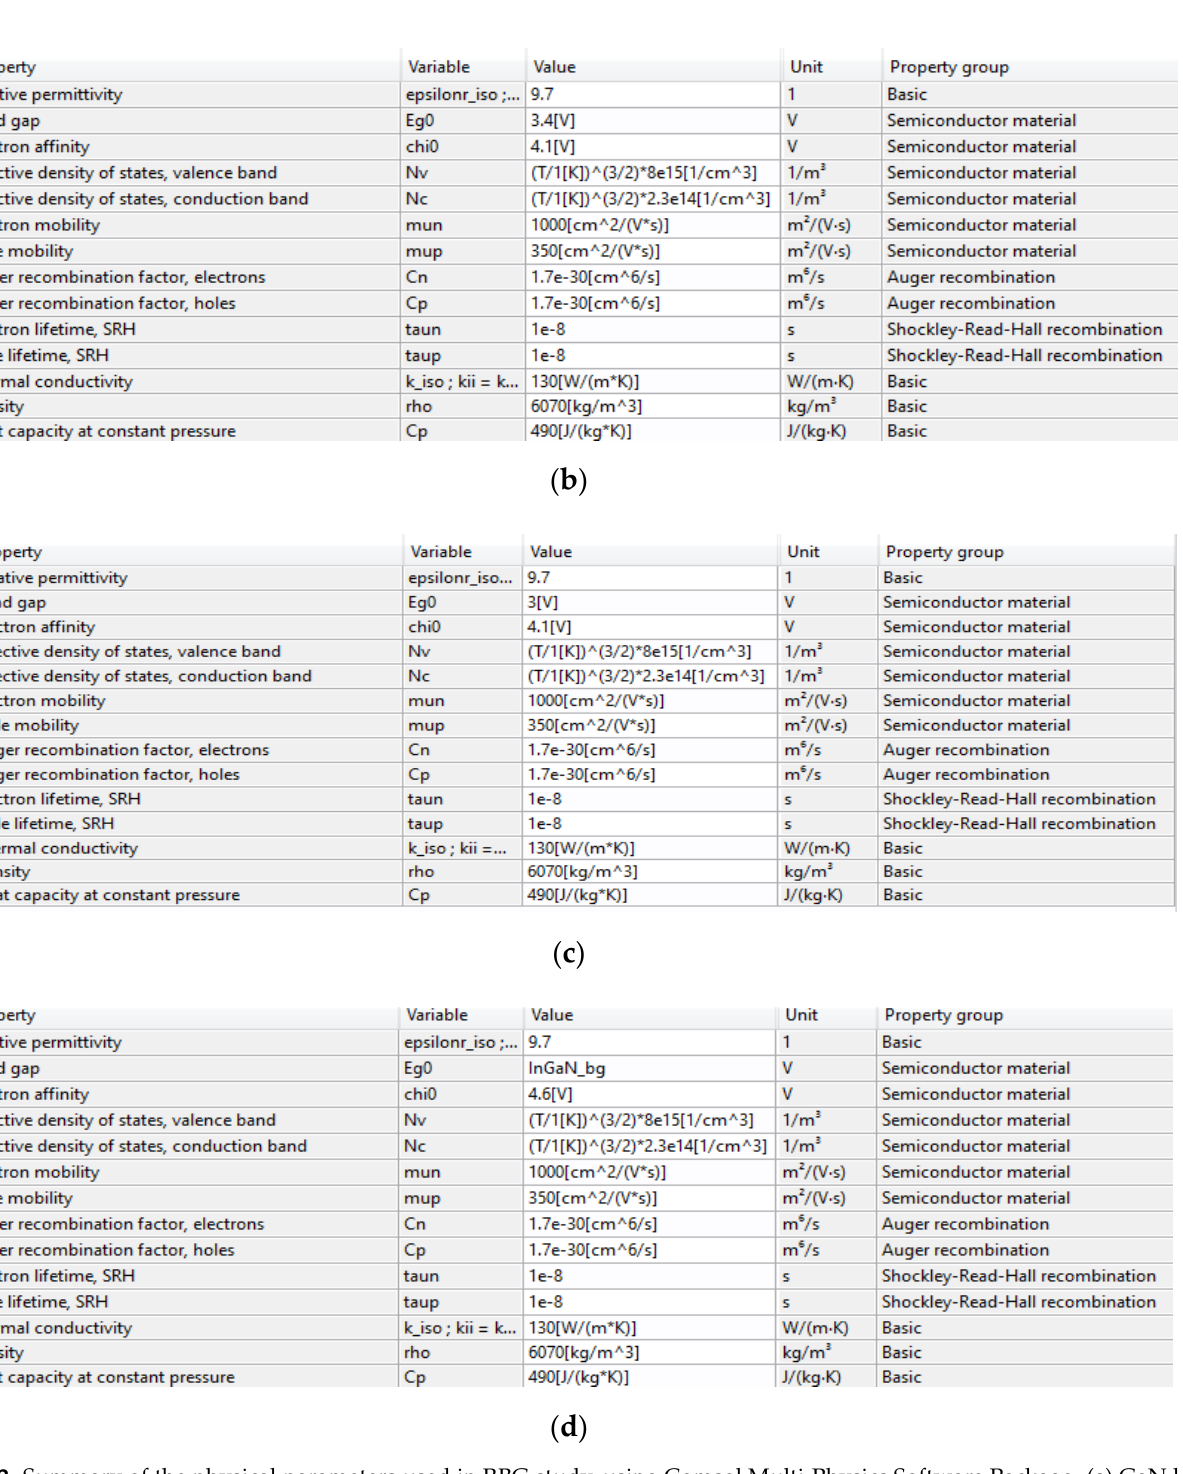
Figure 12. Summary of the physical parameters used in RBG study, using Comsol Multi-Physics Software Package. ( a ) GaN layer parameters for λ = 450 nm; ( b ) GaN layer parameters for λ = 525 nm; ( c ) GaN layer parameters for λ = 650 nm; ( d ) InGaN layer parameters.